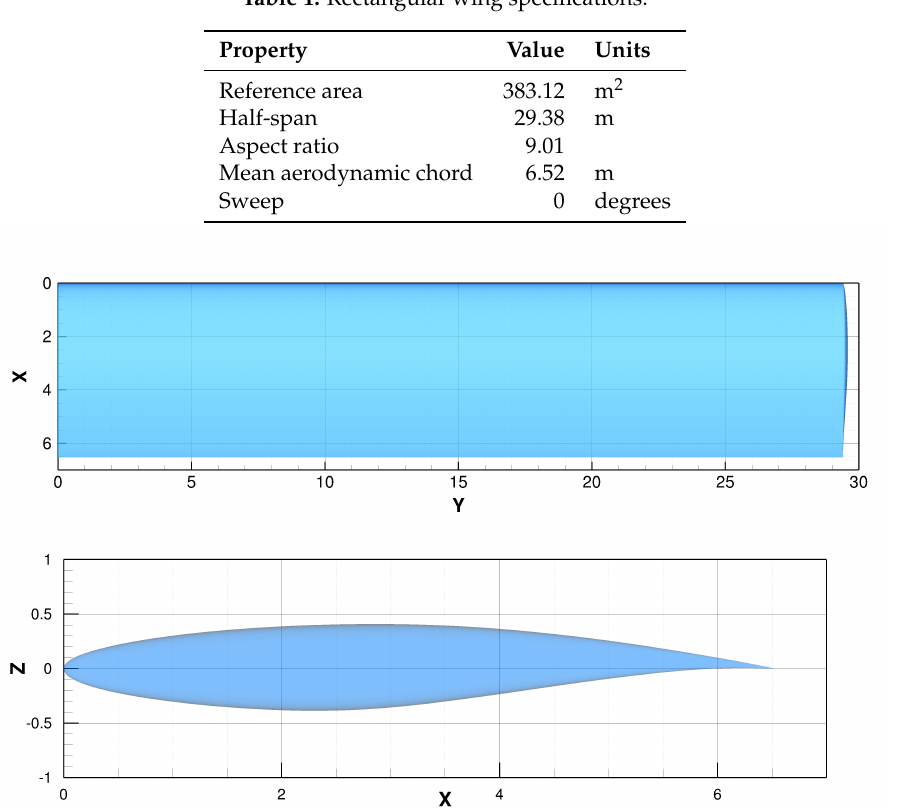
Table 1. Rectangular wing specifications.